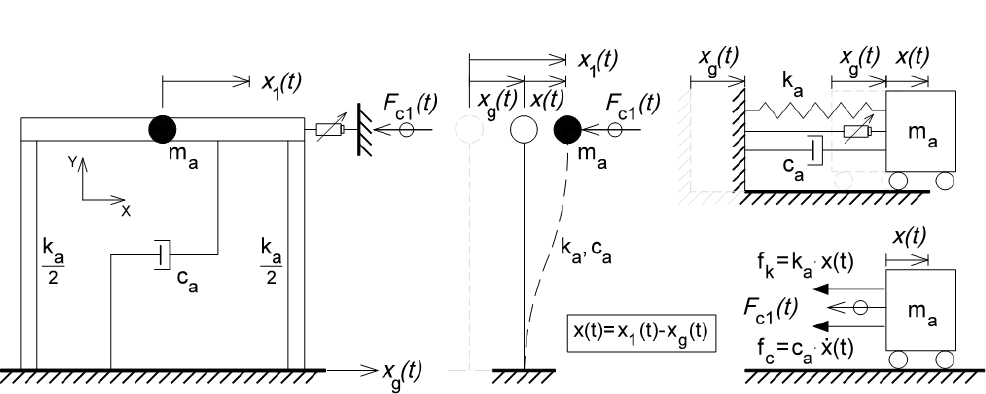
Figure 1. Single degree-of-freedom (SDOF) system with a damper under earthquake